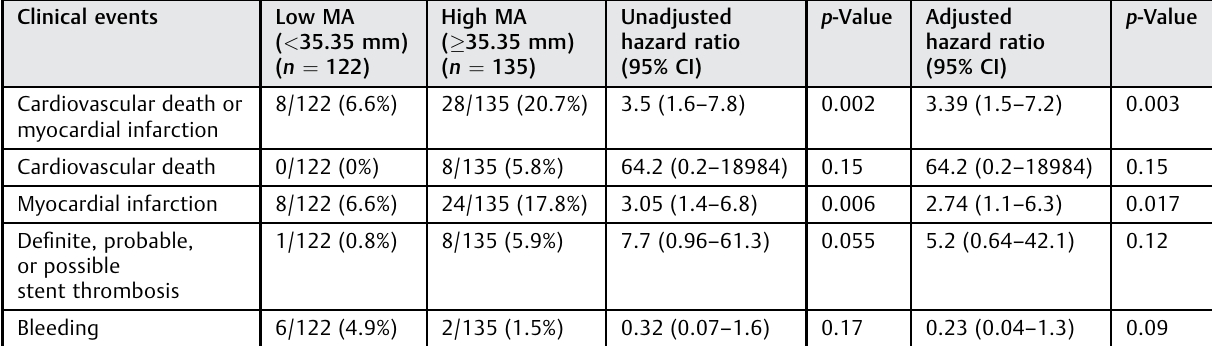
Table 3 Unadjusted and adjusted hazard ratio for clinical outcomes associated with high and low TEG MA in Cox regression analysis Clinical